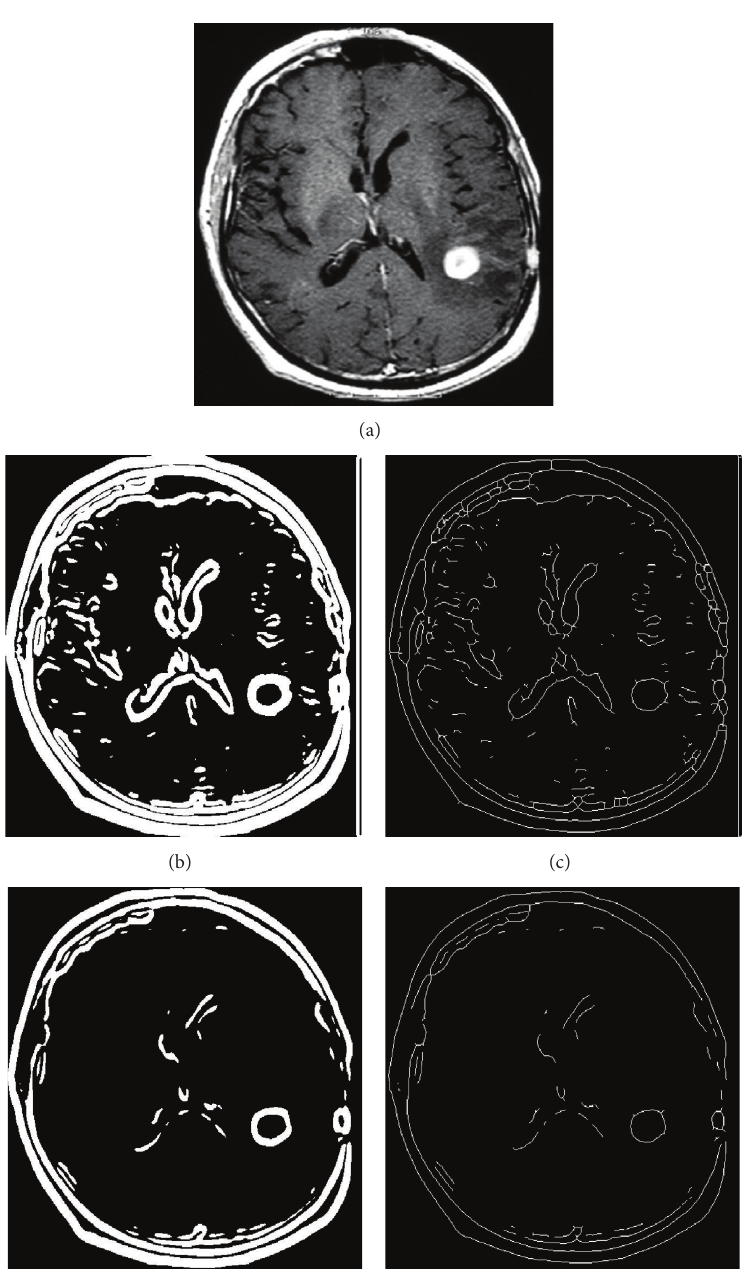
Figure 3: Edges using 𝑘 -means and FCM clustering after GWT; (a) original, (b) 𝑘 -means clustering, (c) skeleton of (b), (d) FCM clustering, and (e) skeleton of